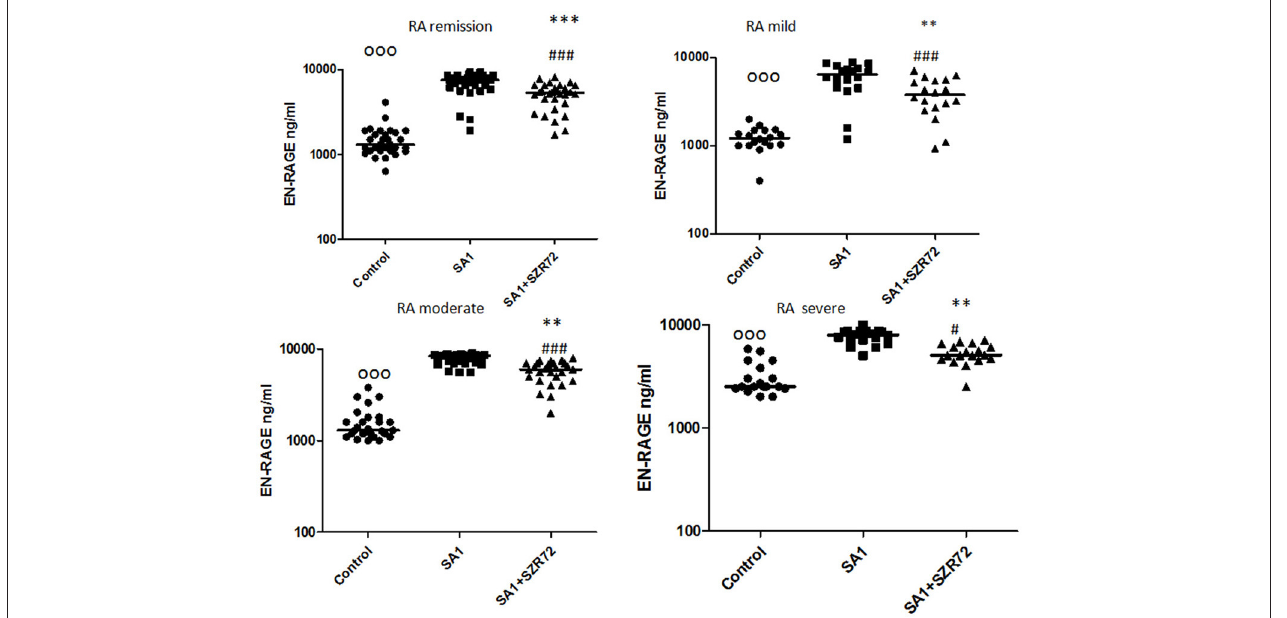
FIGURE 9 | The effect of SZR72 on S100A12 (EN-RAGE) production in human whole blood cells of various groups of patients with RA stimulated by heat-inactivated Staphylococcus aureus. Each dot represents the individual value for one subject, and the horizontal lines denote the medians. Significance was determined by the Friedman’s test. Remission group: n = 30, p < 0.0001; control vs. SA1, ooo p < 0.001; control vs. SA1 + SZR72, ### p < 0.001; ***SA1 vs. SA1 + SZR72, p < 0.001 significant according to the Dunn’s post-test. Mild group: n = 18, p < 0.0001; control vs. SA1, ooo p < 0.001; control vs. SA1 + SZR72, ### p < 0.001; **SA1 vs. SA1 + SZR72, p < 0.01 significant with Dunn’s post-test, moderate group: n = 27, p < 0.0001, control vs. SA1, ooo p < 0.001; control vs. SA1 + SZR72, ### p < 0.001; SA1 vs. SA1 + SZR72, ** p < 0.01, according to the Dunn’s post-test. Severe group: n = 18, p < 0.0001; control vs. SA1 ooo p < 0.001, control vs. SA1 + SZR72, # p < 0.05; SA1 vs. SA1 + SZR72, ** p < 0.01 according to the Dunn’s post-test.